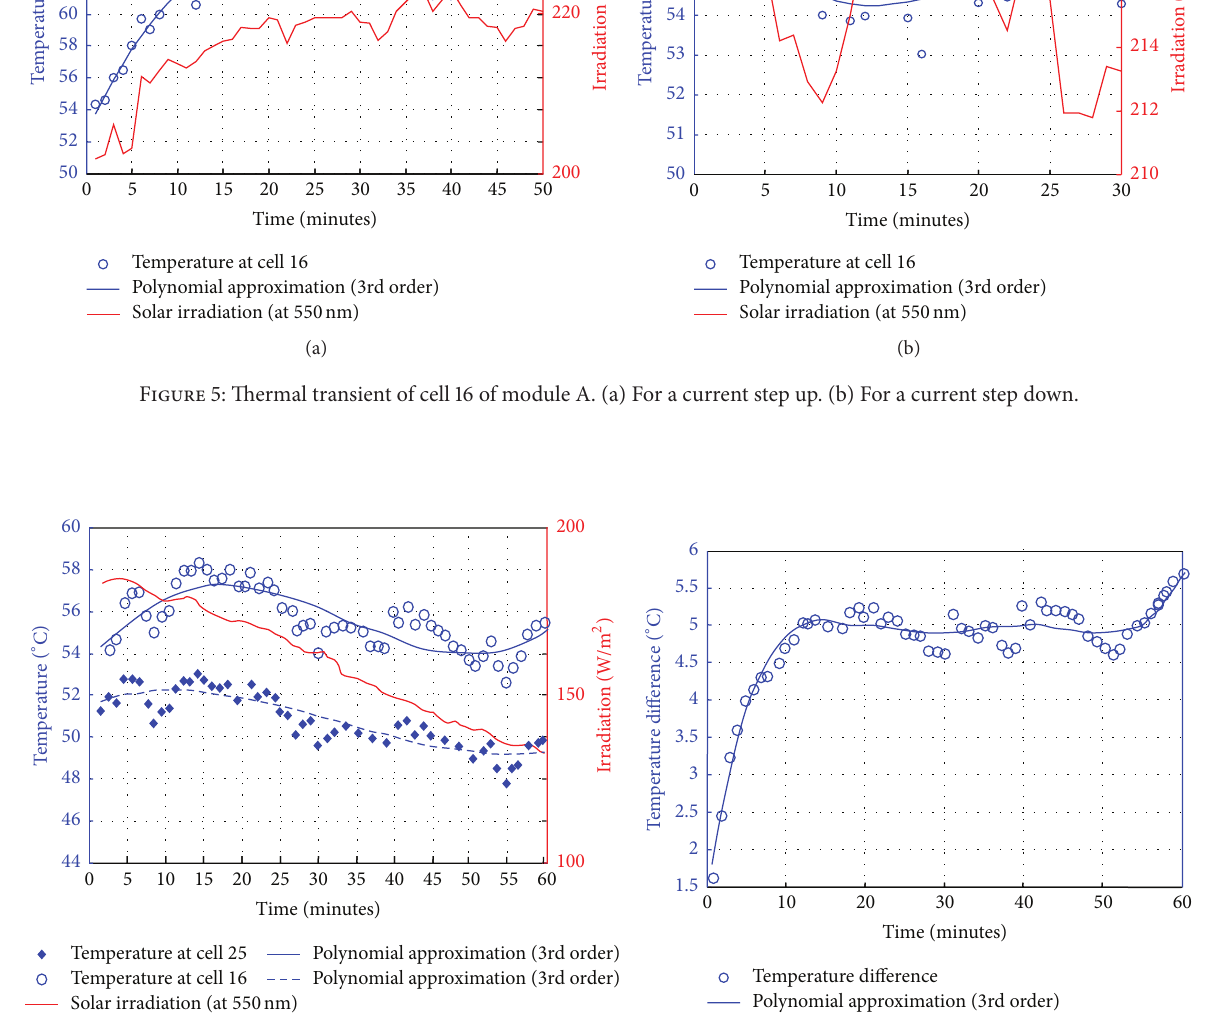
The statistical analysis has an error of ± 1.3, for cells 16 and 25. The difference between both cells was statistically significant ( 𝑡 = −55 – 13 , df = 59 , and 𝑝 = 1.85𝑒 − 52